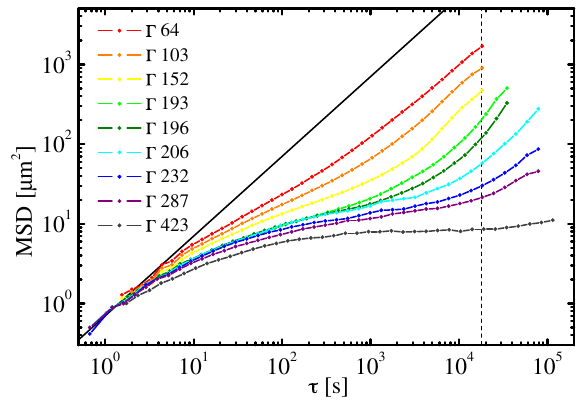
FIG. 1. MSD for both species of particles at different temper- atures. The kink at high temperatures slowly develops into a plateau. However, it is impossible to distinguish unambiguously between solid and fluid states from this dynamical data. The solid black line corresponds to free diffusion and the vertical dashed line to the sampling time Δ t used in the following analysis to determine the